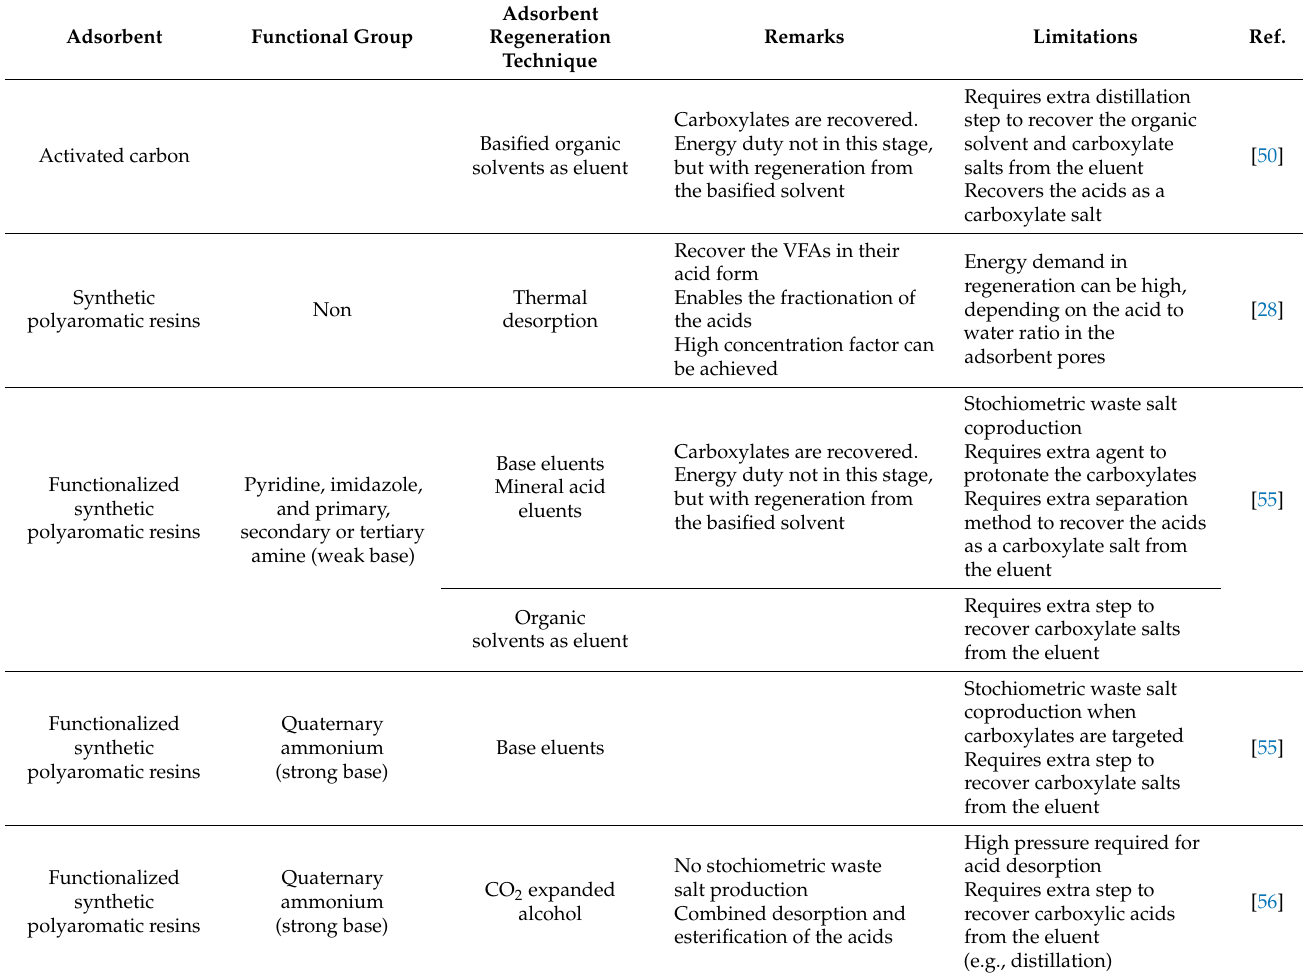
Table 2. General comparison between the desorption techniques applied for various adsorbents in recovering carboxylic acid from a fermentation